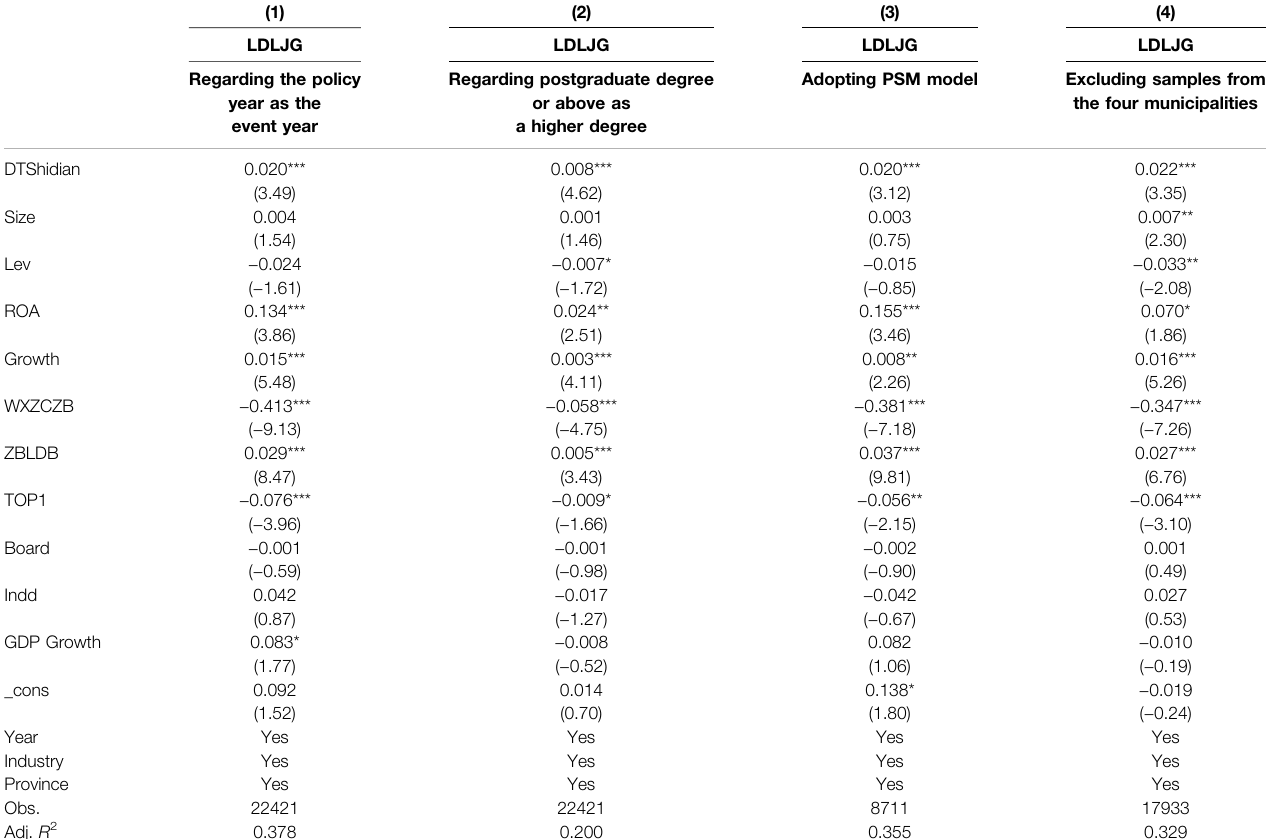
TABLE 6 | Robustness test